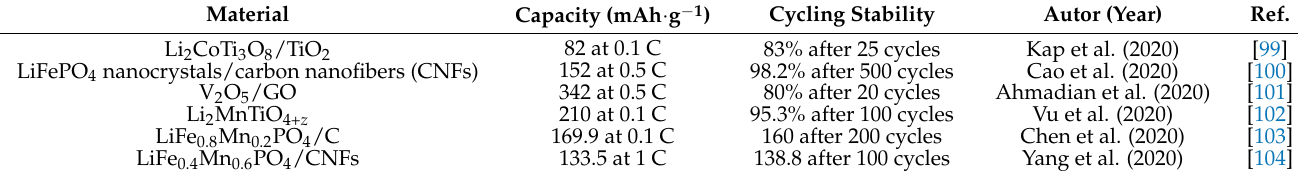
Table 1. The most recent approaches toward fabrication of nanofibrous cathodes.